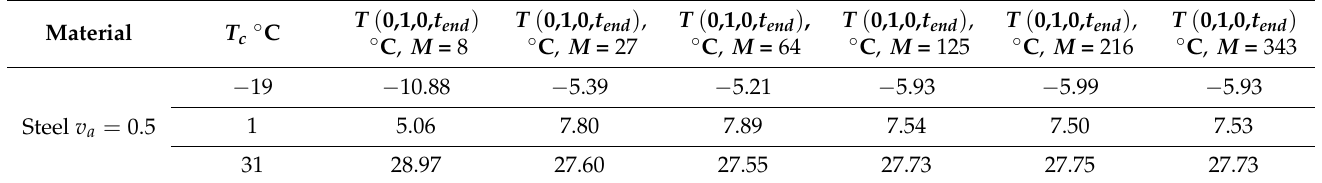
Table 1. Studies involving the number of T-functions in (25) regarding computation